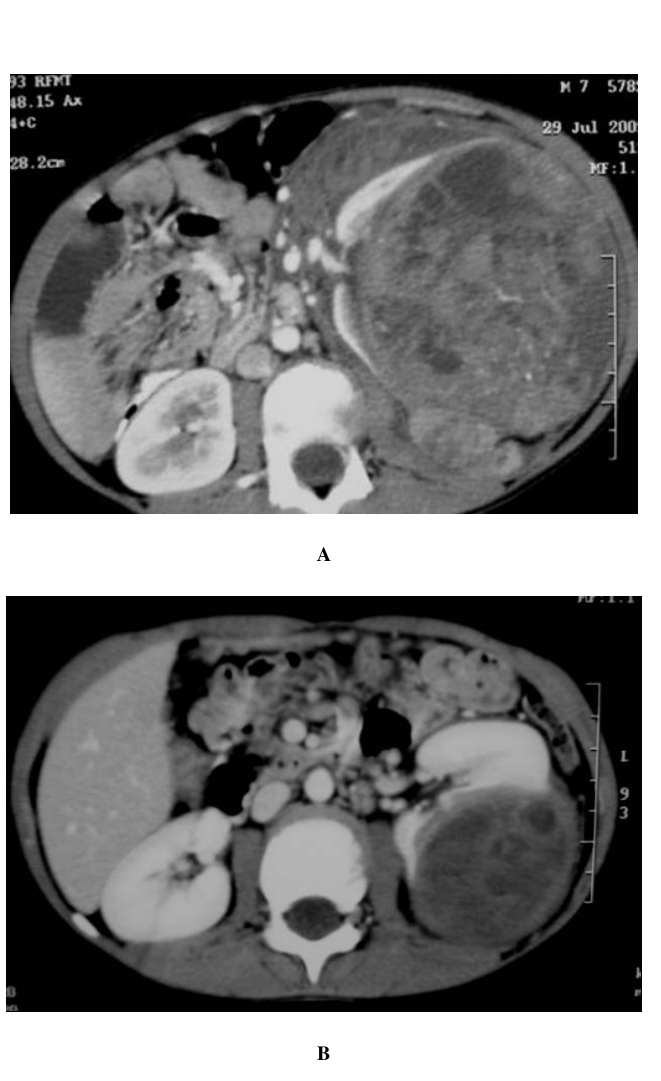
FIGURE 1. Postcontrast axial CT scan of the kidneys in a 5-year-old male shows (A) prechemotherapy, there is a large mass replacing the left kidney with perirenal extension; (B) postchemotherapy, there is marked reduction in the size of the